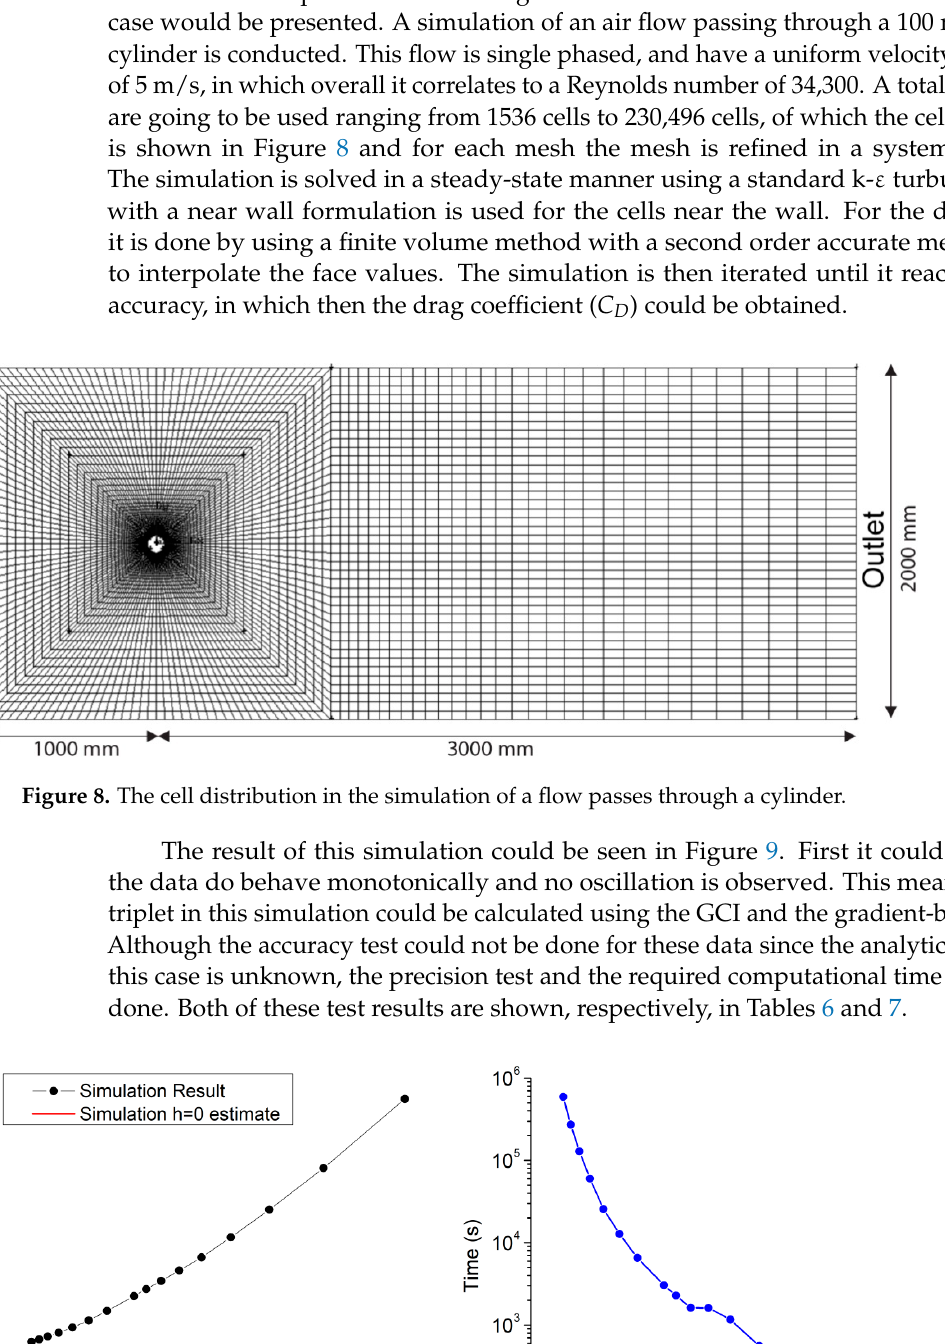
( b ) Figure 7. The MMS simulation result that has switching conditions: ( a ) Case 20; ( b ) Case 35. Judging by the data from Table 4, in which the data on this table show the averaged